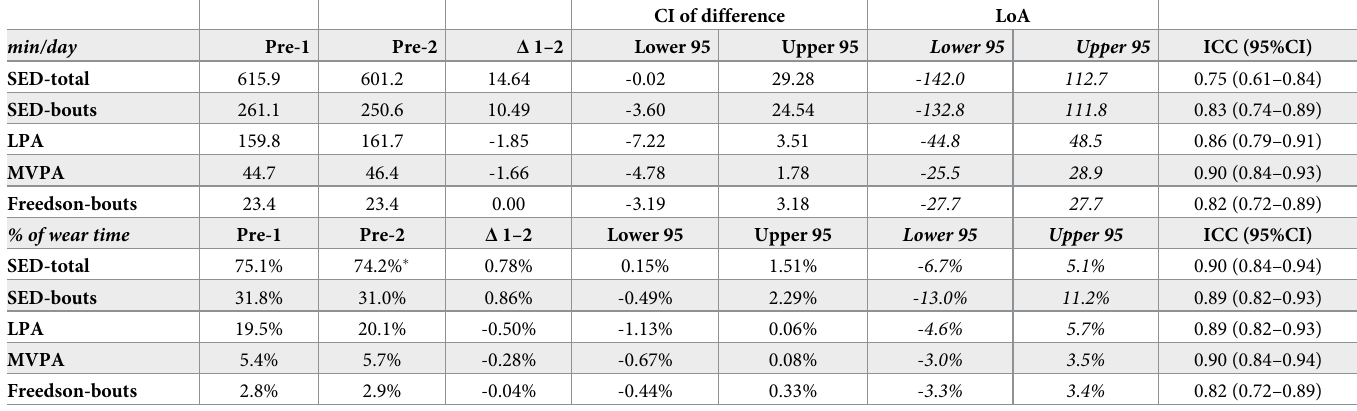
Table 2. The exercise group Pre-1-test and Pre-2-test mean values, mean difference Pre1-Pre-2 ( Δ 1–2), 95% CI, limits of agreement (LoA) and intraclass correlation coefficient, ICC (95% CI) for SED-total, SED-bouts, LPA, MVPA and Freedson bouts in min/day and in % of wear-time. Significant differences between the two pre- tests (p < 0.05), is marked with an asterisk ( � ) in the